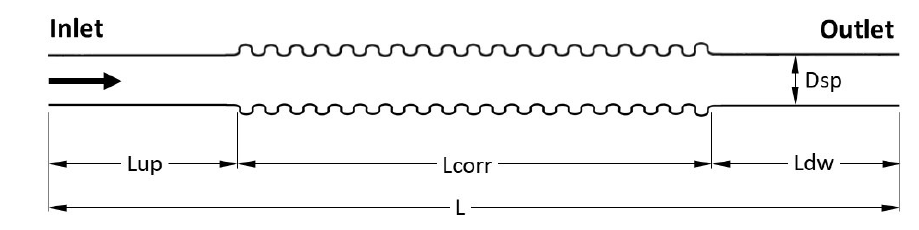
Figure 2. Complete pipe system consisting of smooth pipe segments attached to a corrugated segment (not to